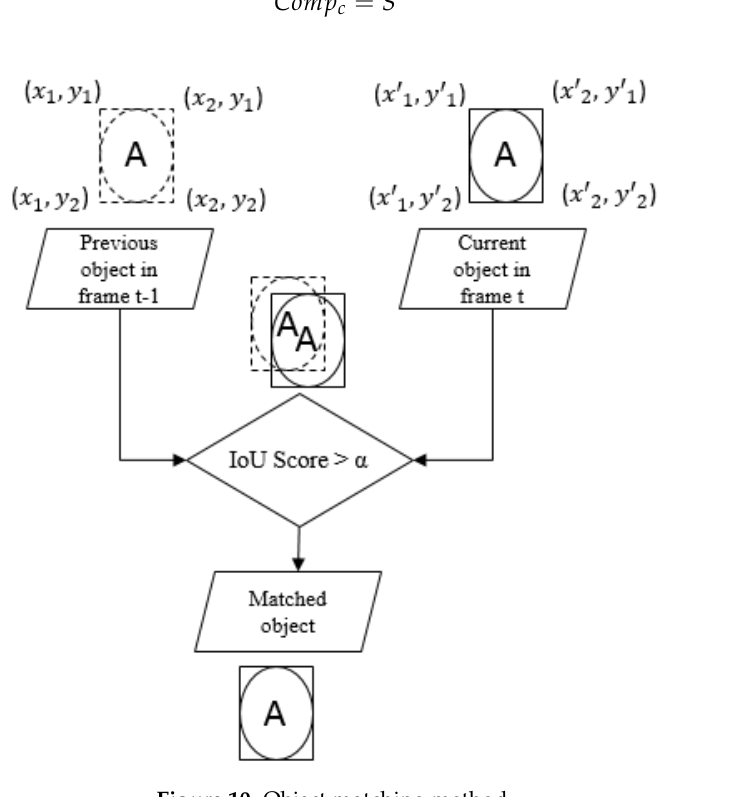
Figure 10. Object matching